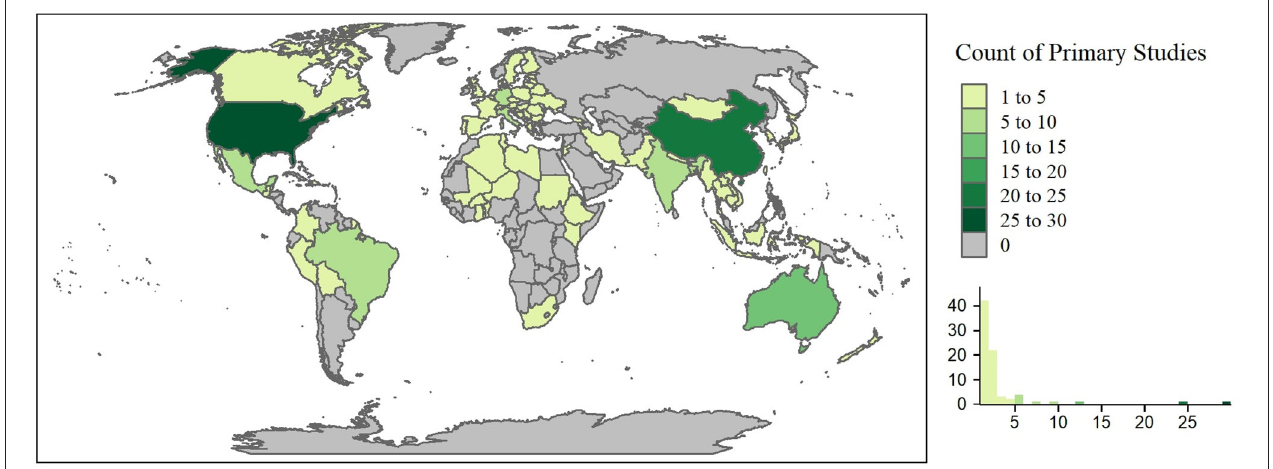
FIGURE 5 | Geographic location of the primary studies by